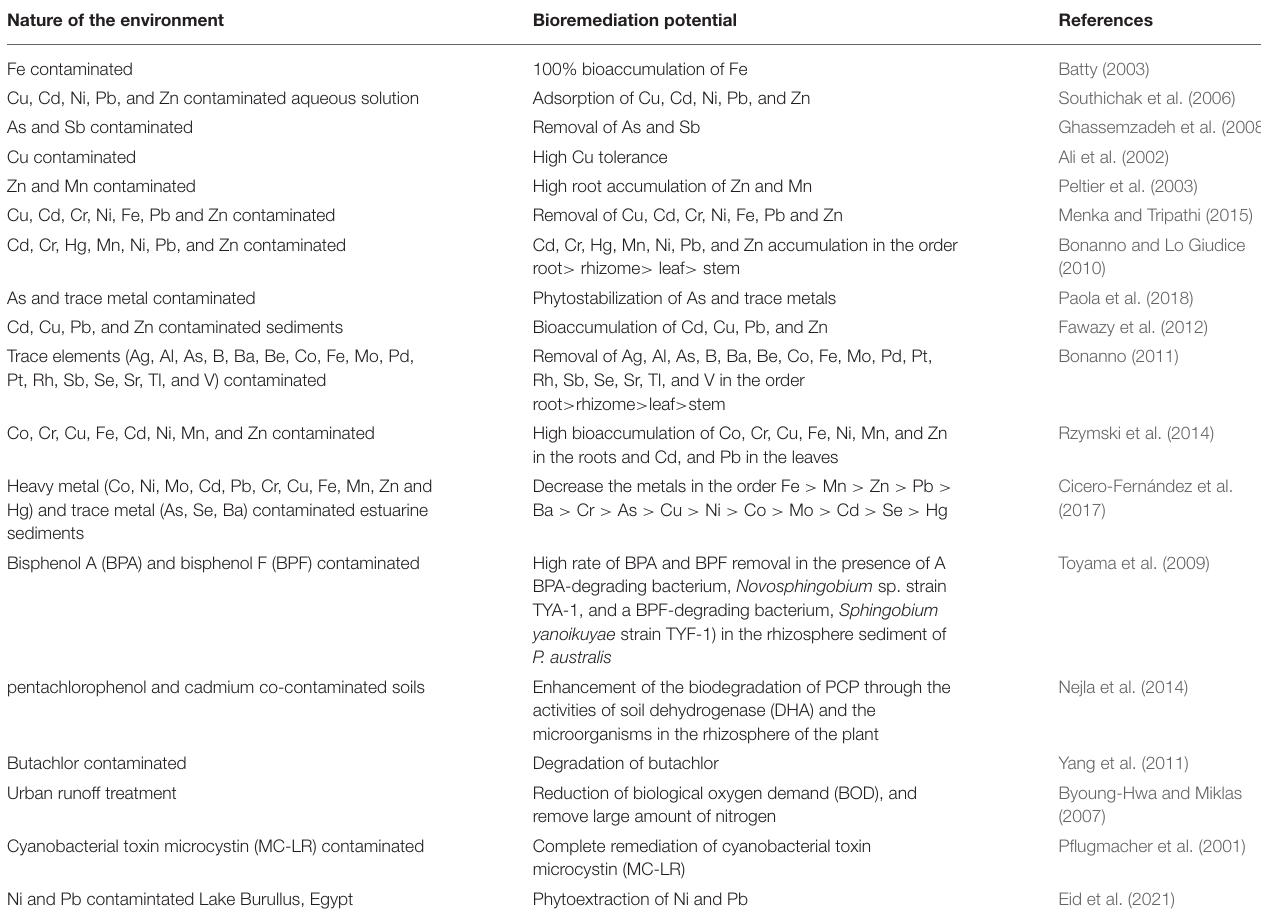
TABLE 3 | Remediation ability of P. australi s in diverse polluted